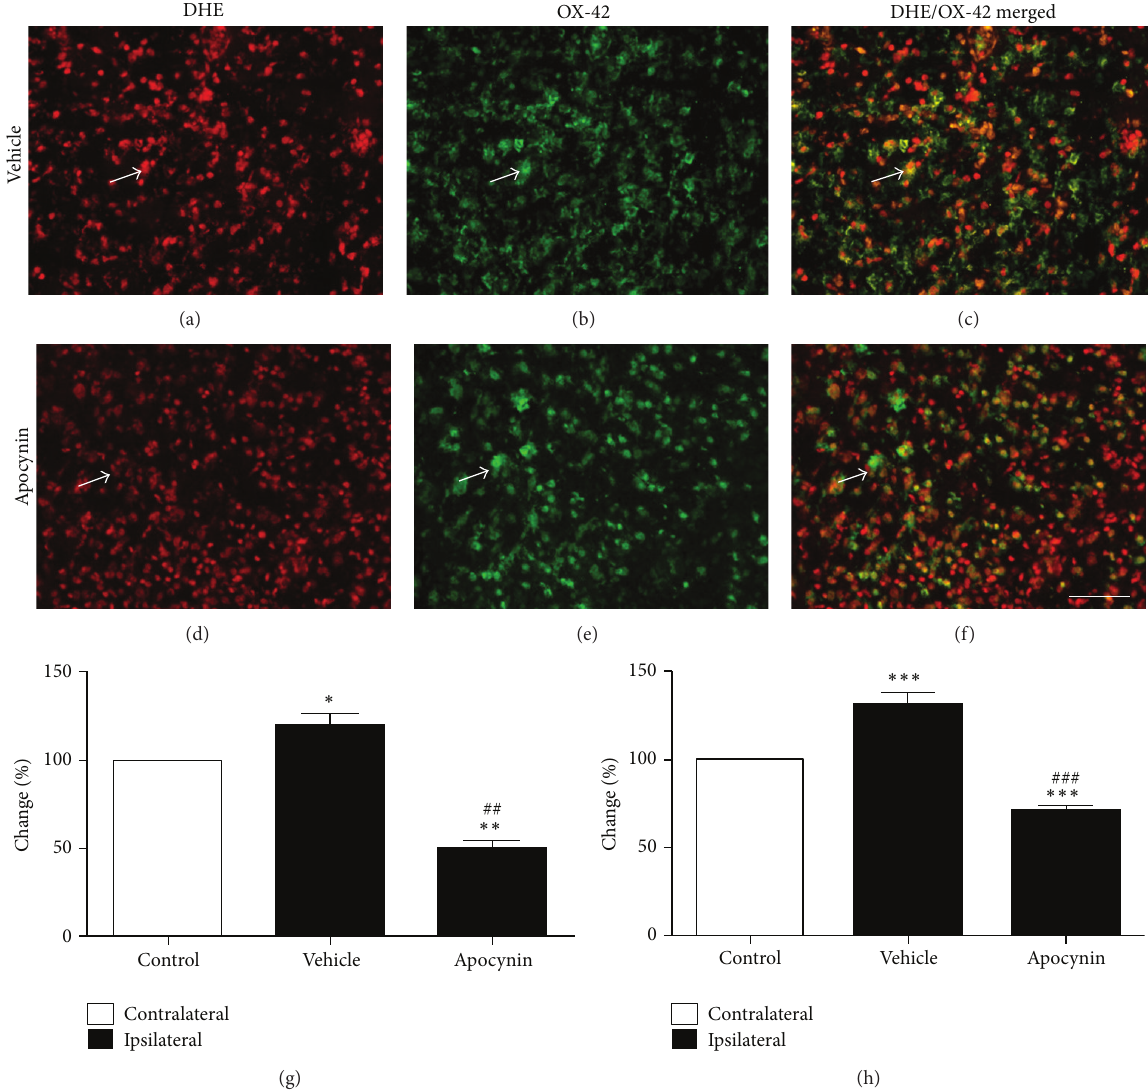
F 4: Immunohistochemical localization of activated microglia/macrophages (OX42) and concurrent superoxide generation (dihy- droethidium) in stroke-affected brain following vehicle control ((a)–(c)) and apocynin treatments ((d)–(f)). Fluorescence micrographs of the ipsilateral cortex with superoxide sensitive dihydroethidium ((a), (d)), the microglia marker OX42 ((b), (e)) and merged images ((c, (f)). Arrows point to a typical activated microglia cell in the ischemic core from both treatment groups. �uanti�cation of microglial speci�c superoxide release in the core infarct region detected in situ 3 days aer stroke in the isilateral cortex (stroke affected; solid bars) compared with the contralateral cortex (nonaffected; open bar) in vehicle control and apocynin treated rats (g). �uanti�cation of microglial speci�c superoxide release in the core infarct region in the ipsilateral striatum compared with the contralateral striatum in vehicle control and apocynin-treated rats (h). Relative �uorescence was �uanti�ed by tracing around cells double labelled with OX-42 and analysed using